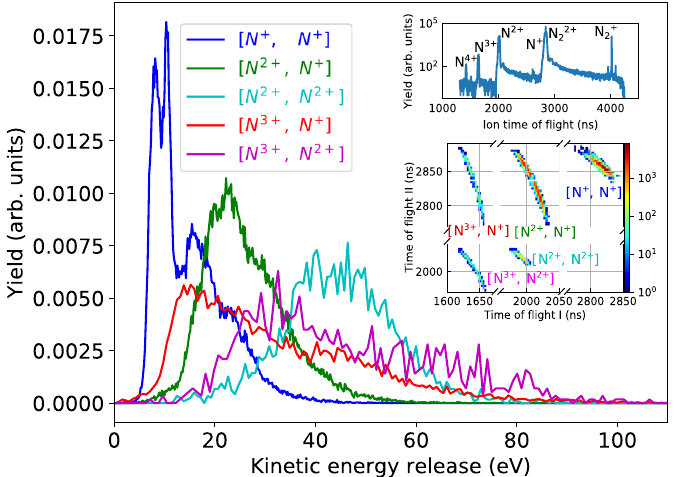
Figure 2. KER for the five strongest ion-ion coincidence channels observed in the interaction of 503-eV, 100-fs (nominal value estimated from the length of electron bunch used for X-ray generation), 10-μJ XFEL pulse with N 2 molecules. The insets show the corresponding ion time-of-flight spectrum (top) and the photoion-photoion coincidence (PIPICO) map